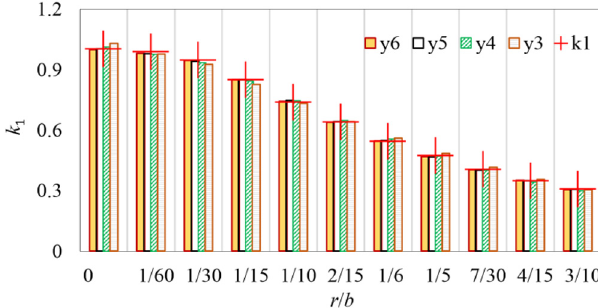
Fig. 16. The fi tting reduction coef fi cient k 1 of the square plate with circular